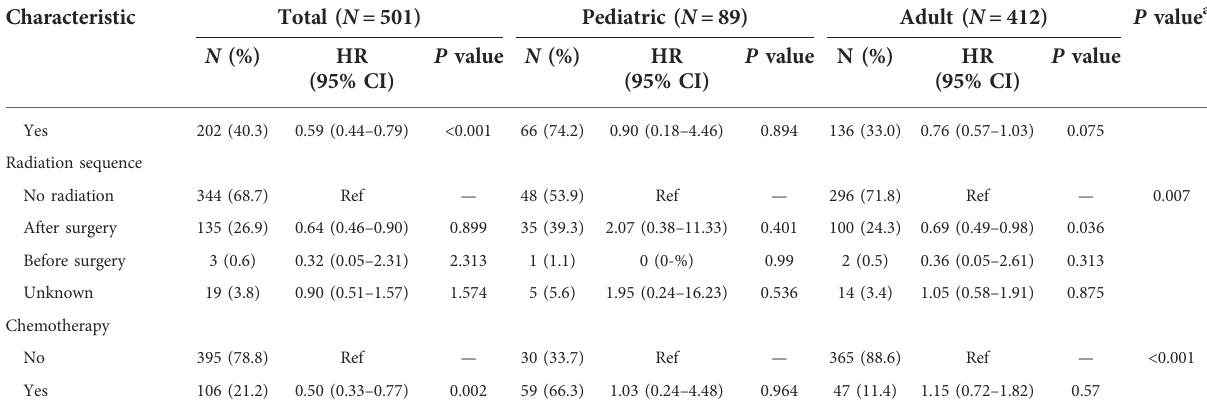
According to the results of multivariate Cox regression, the signi fi cant prognostic factors (age, tumor extent, and marital status) were used for plotting Kaplan – Meier survival curves. The pediatric patients (MST: 420 months) showed signi fi cantly better long-term survival than adults (MST: 145 months; Figure 3B , P < 0.001). Obviously, localized stage patients also demonstrated better survival than the regional stage, followed by the distant stage with the worst survival ( Figure 3C , P < 0.001). As for marital status, the never-married patients had better survival outcomes than others, and the widowed people performed worst ( Figure 3D , P < 0.001).